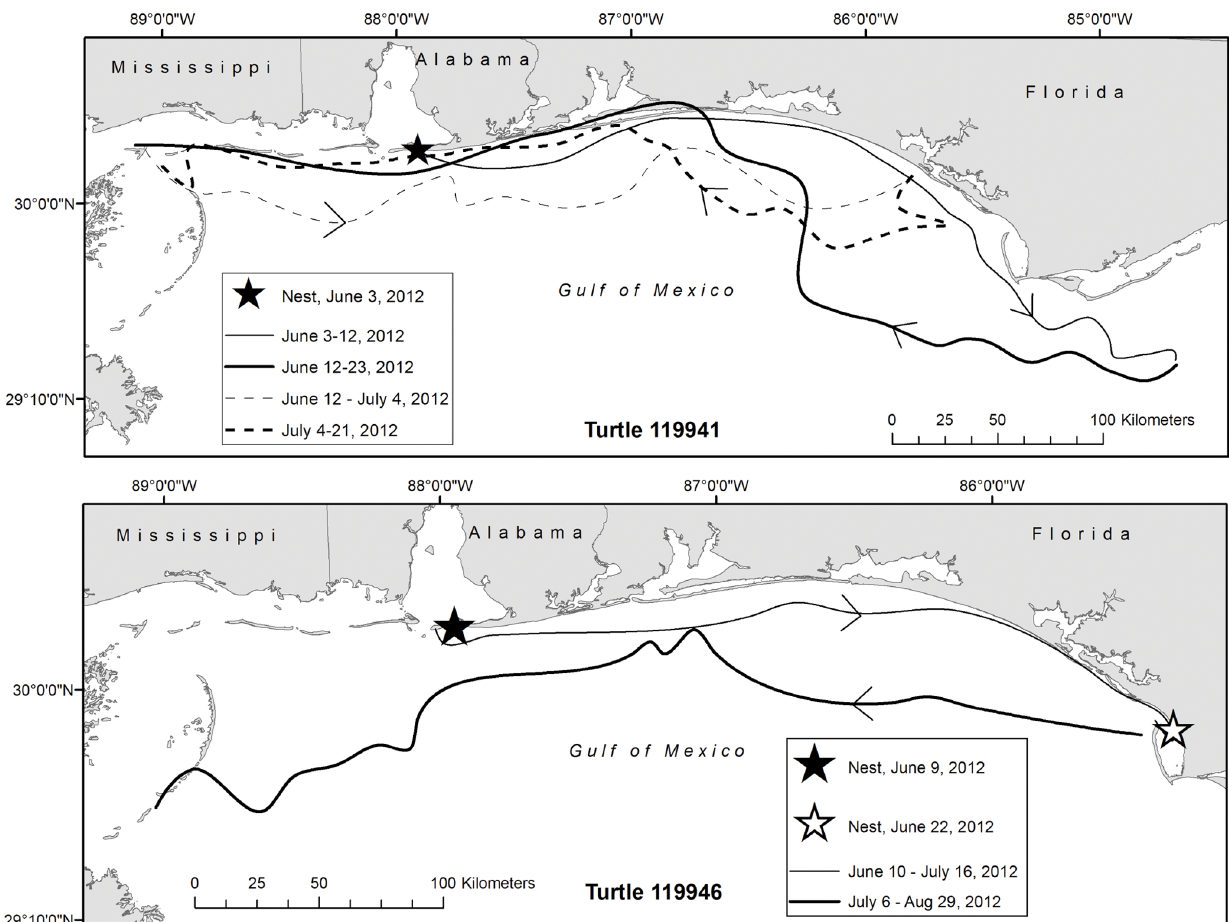
Figure 2. Loggerhead ‘‘exchanges’’ between study sites. Tracks of satellite-tagged adult female loggerheads ( Caretta caretta ) 119941 and 119946 during the inter-nesting period in 2012 (A); tracks of satellite-tagged adult female loggerheads 108172 (2011) and 119940 (2012) during the inter-nesting period (B).